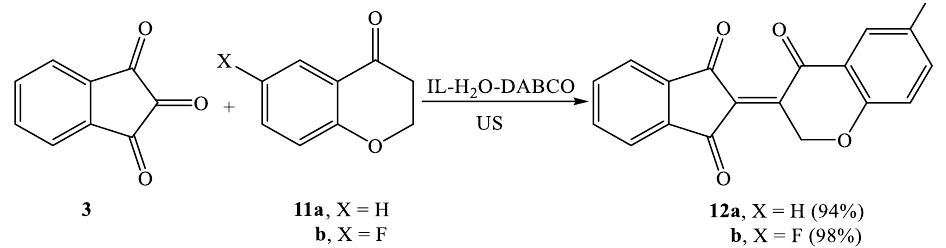
Table 2. Knoevenagel condensation of isatins with rhodanines under different